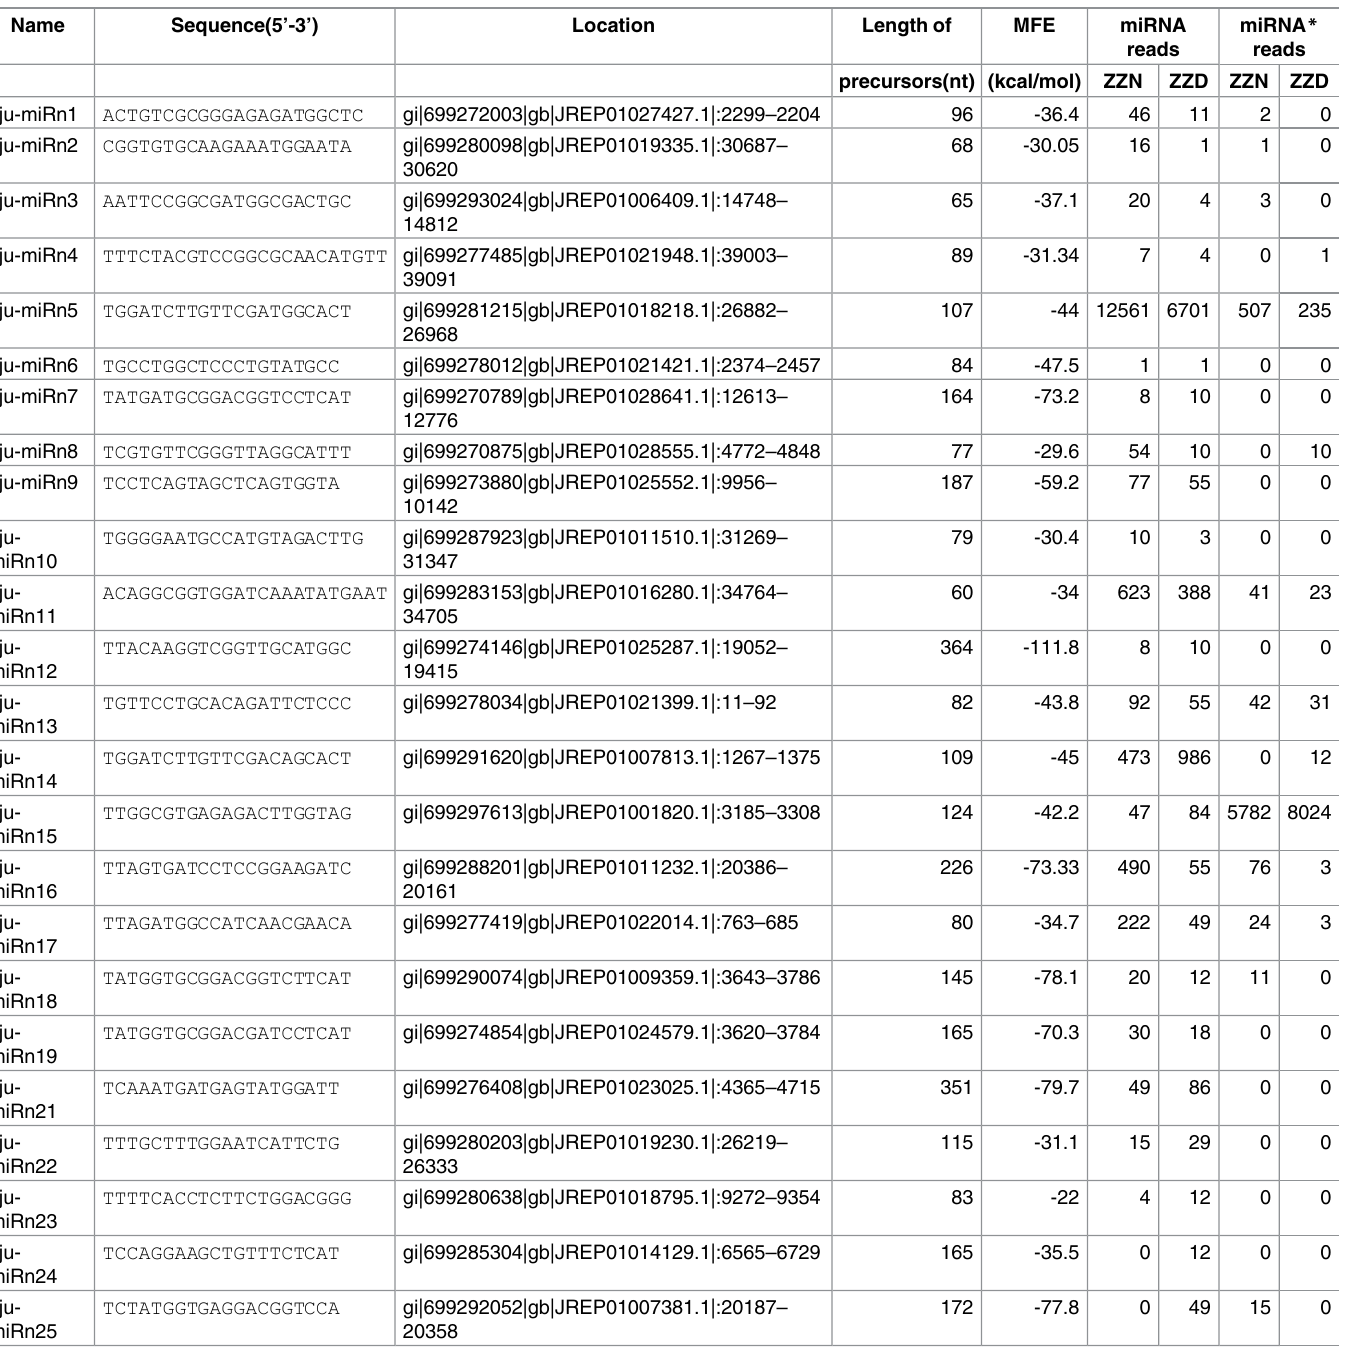
Table 3. The novel miRNAs identified in Z . jujuba